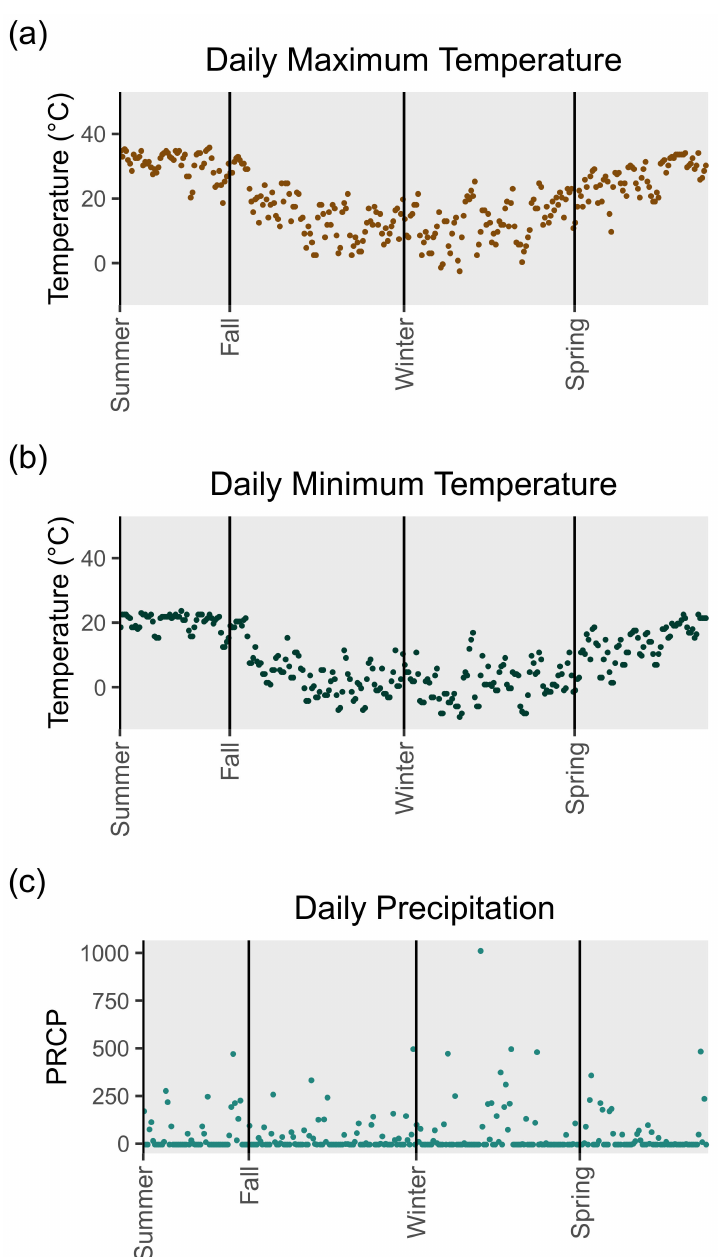
Figure A1. Scatterplots of ( a ) daily maximum temperature ( b ) daily minimum temperature and ( c ) daily precipitation for the duration of the sampling period in Nashville,